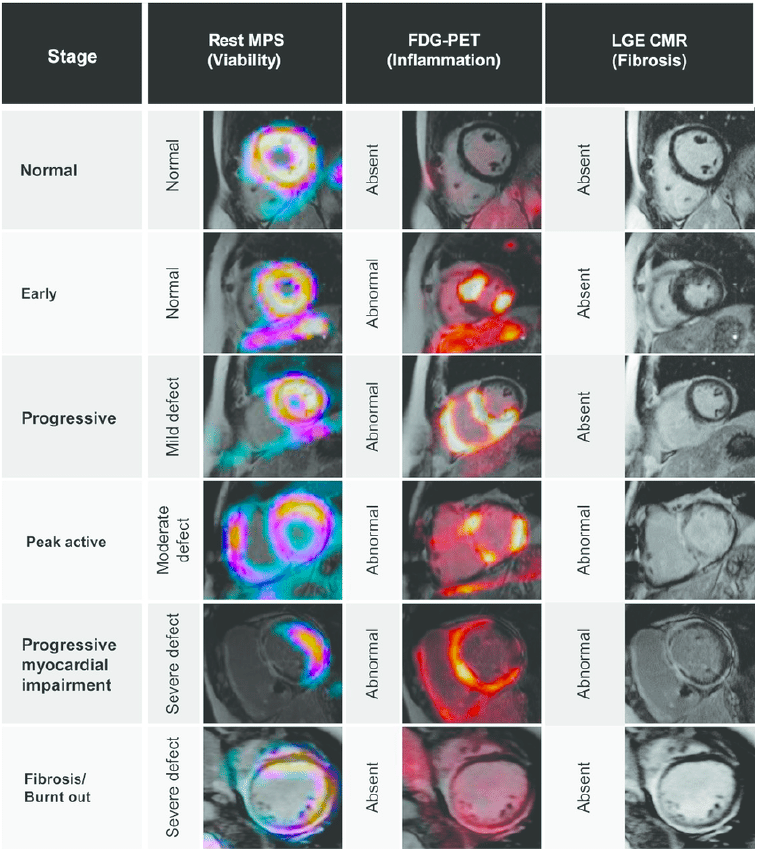
Figure 3. Use of FDG PET for early detection of cardiac sarcoidosis, showing FDG advantages in the ability to detect the activity of inflammation early on, in comparison with resting myocardial perfusion scintigraphy (MPS) and CMR. Figure replicated from [95] under Creative Commons license, provided at https://creativecommons.org/licenses/by-nc/4.0/ (accessed on 1 February 2022). Changes made: Figure legend.